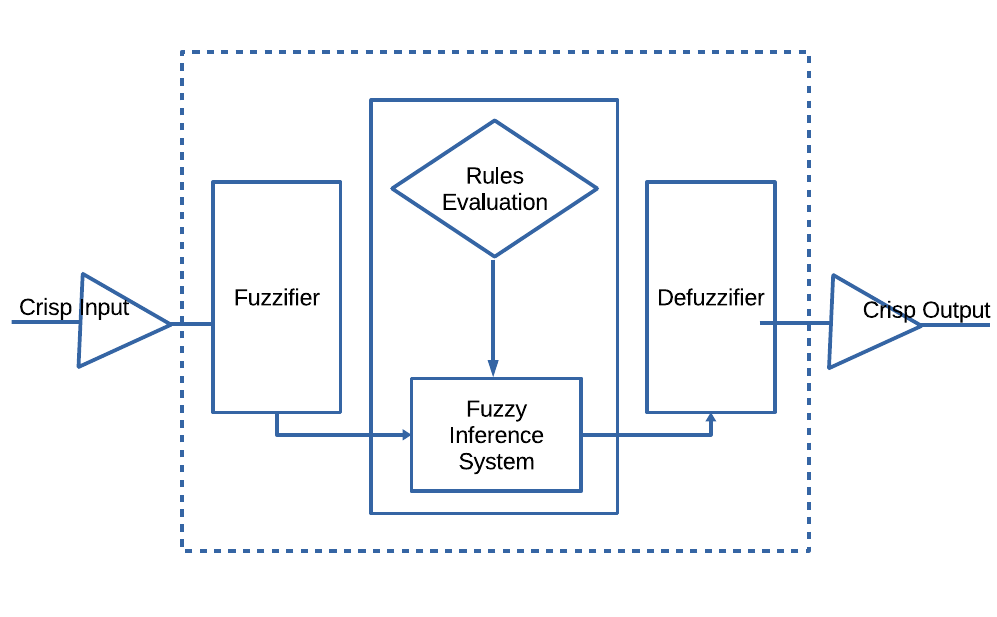
Figure 3. Fuzzy Logic System